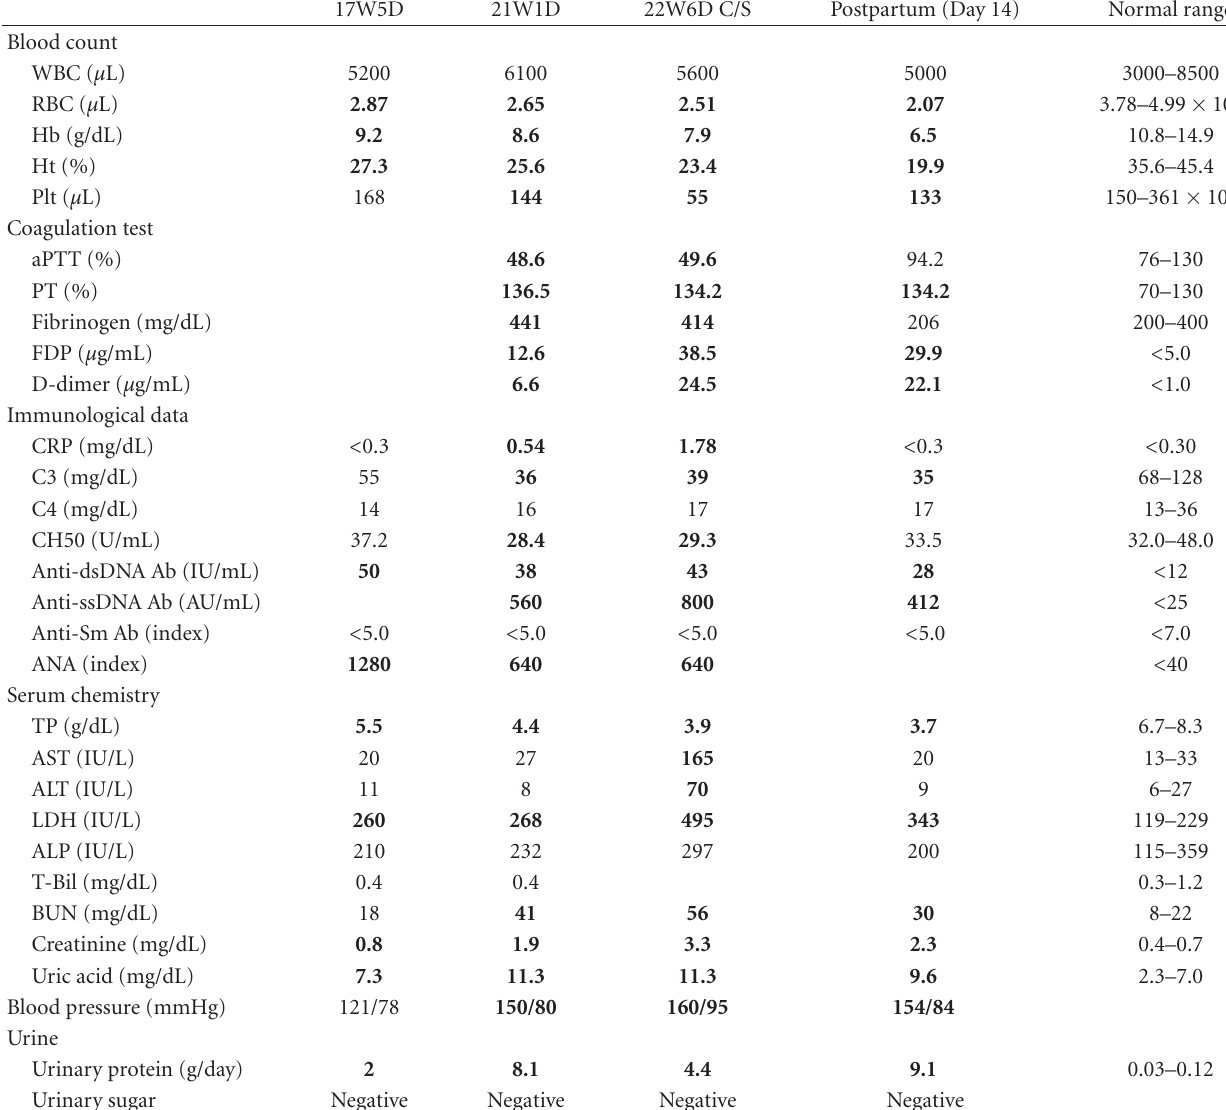
Table 1: Laboratory data (abnormal findings are